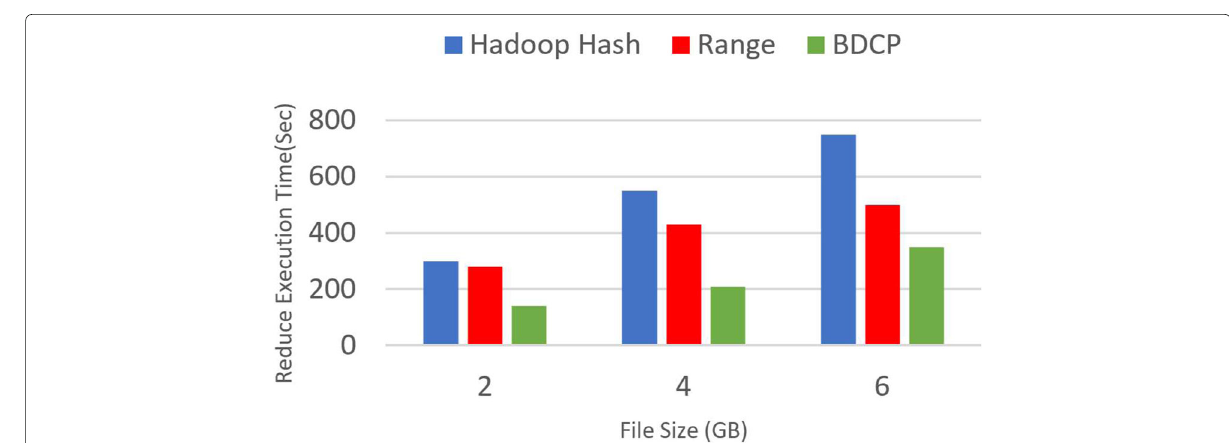
Fig. 18 Sort job on files of sizes, 2, 4, and 6 GB. Skew degree is 1.1